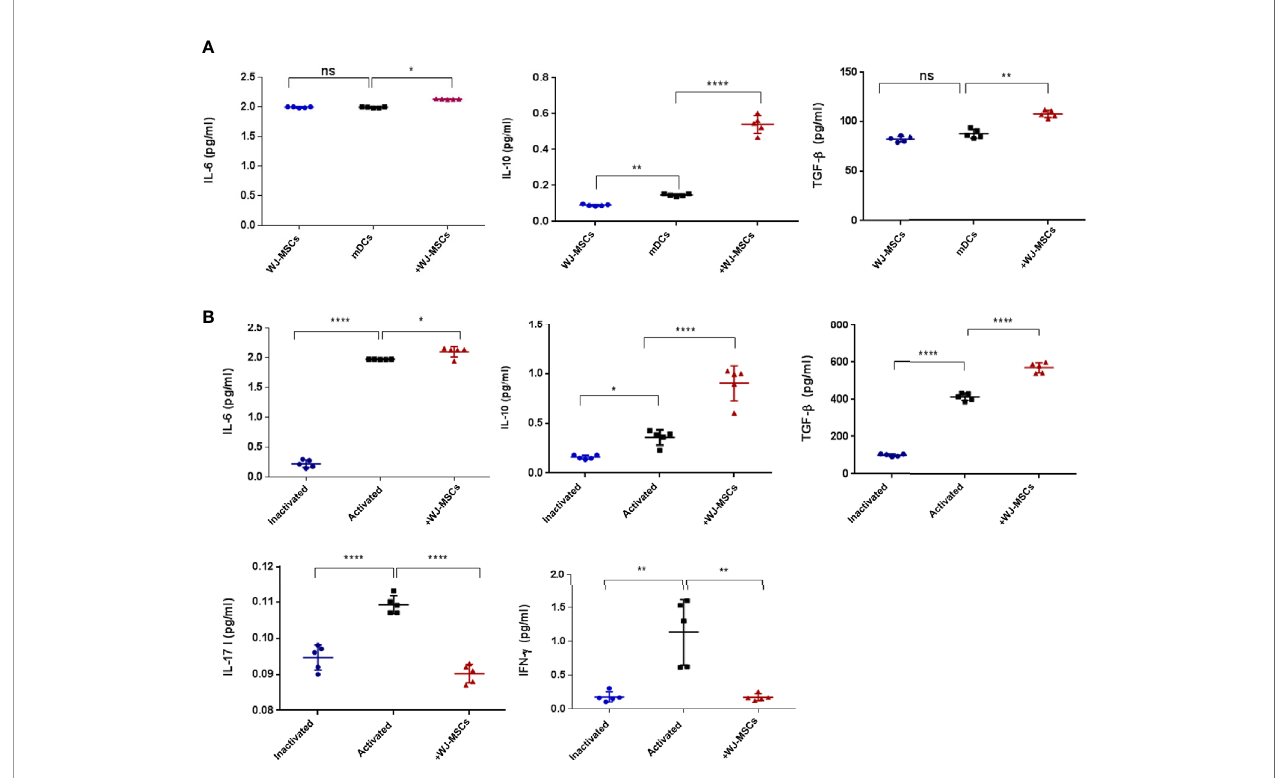
FIGURE 4 | Cytokines secretion level. (A) Mean ± SD levels of secreted IL-6, IL-10, and TGF- b in cell free culture supernatant under the following culture conditions: primed WJ-MSCs alone (blue), GAD65- pulsed mDCs co-cultured without (black) and with primed WJ-MSCs (red). (B) Mean ± SD levels of secreted IL-6, IL-10, TGF- b , IL-17 and IFN- g in cell free culture supernatant under the following culture conditions: inactivated T cells (blue), activated T cells without (black) or with primed WJ-MSCs (red). Data were calculated from fi ve patients. Experiments performed in duplicate for each patient. In all analyses *p < 0.05, **p < 0.01 and ****p < 0.0001. ns, not signi fi